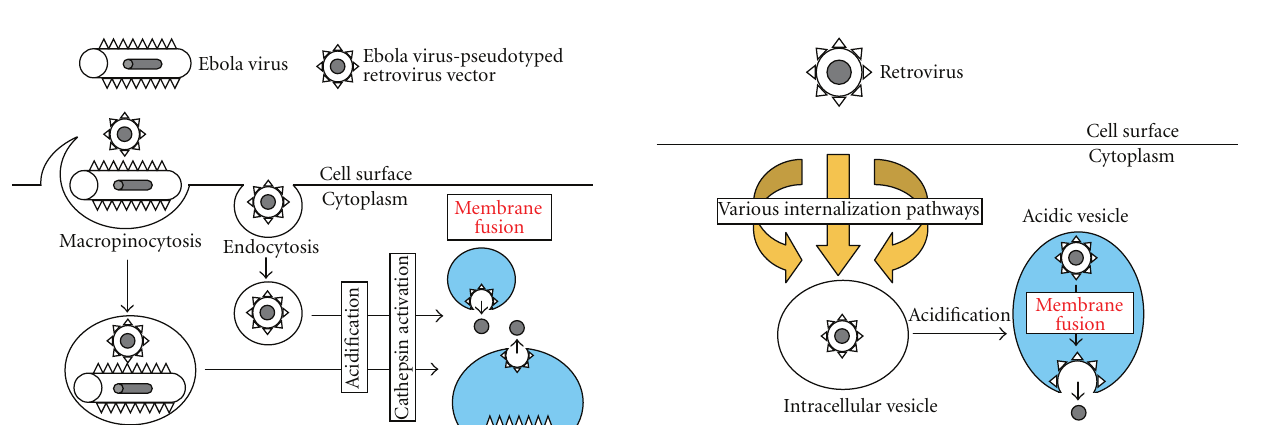
Figure 7: Retrovirus particles are internalized into intracellular vesicles by various pathways, and vesicle acidification is necessary for the